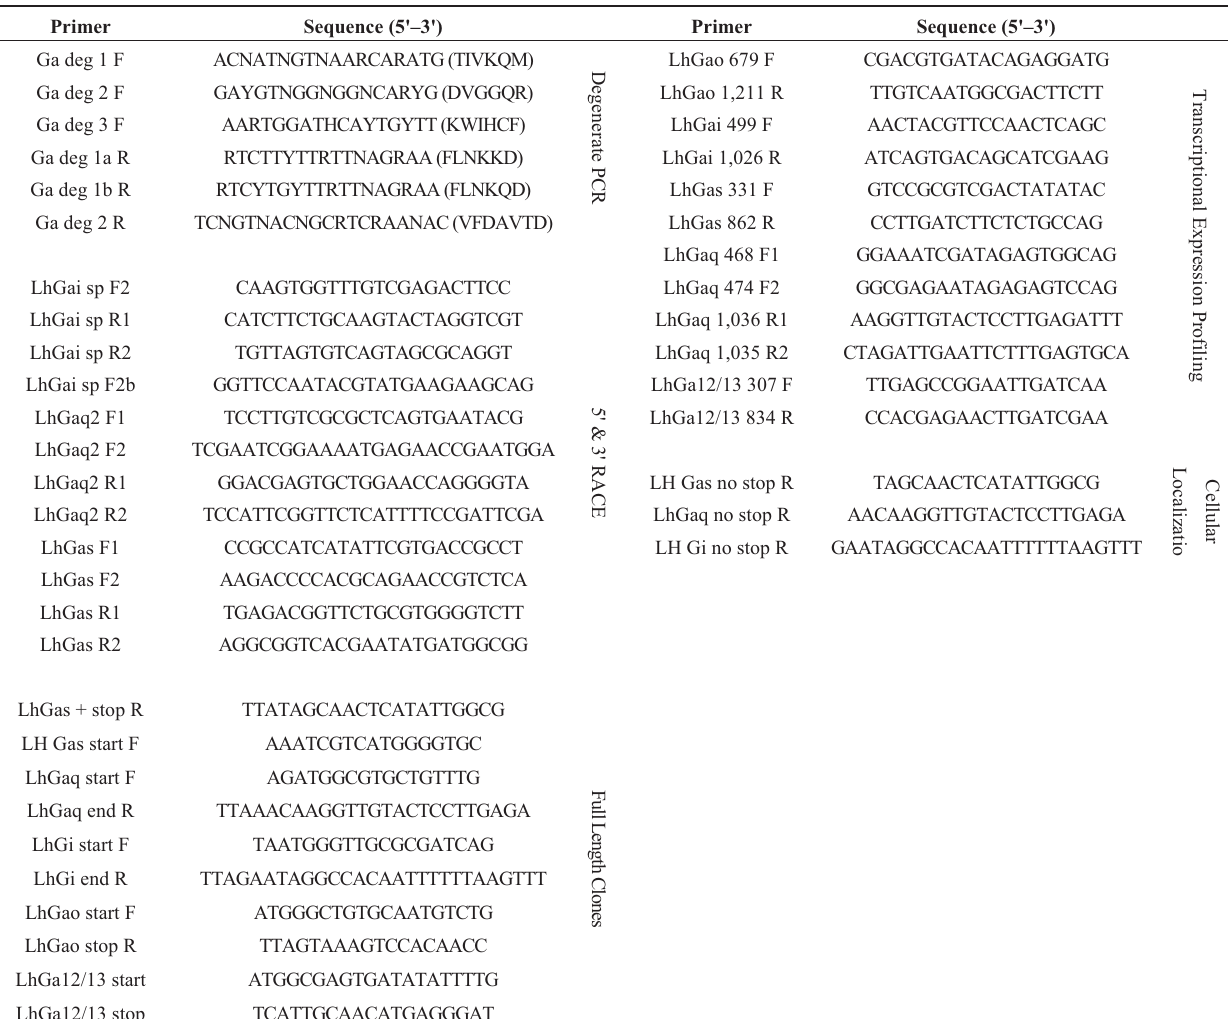
Table 1. Oligonucleotide primers